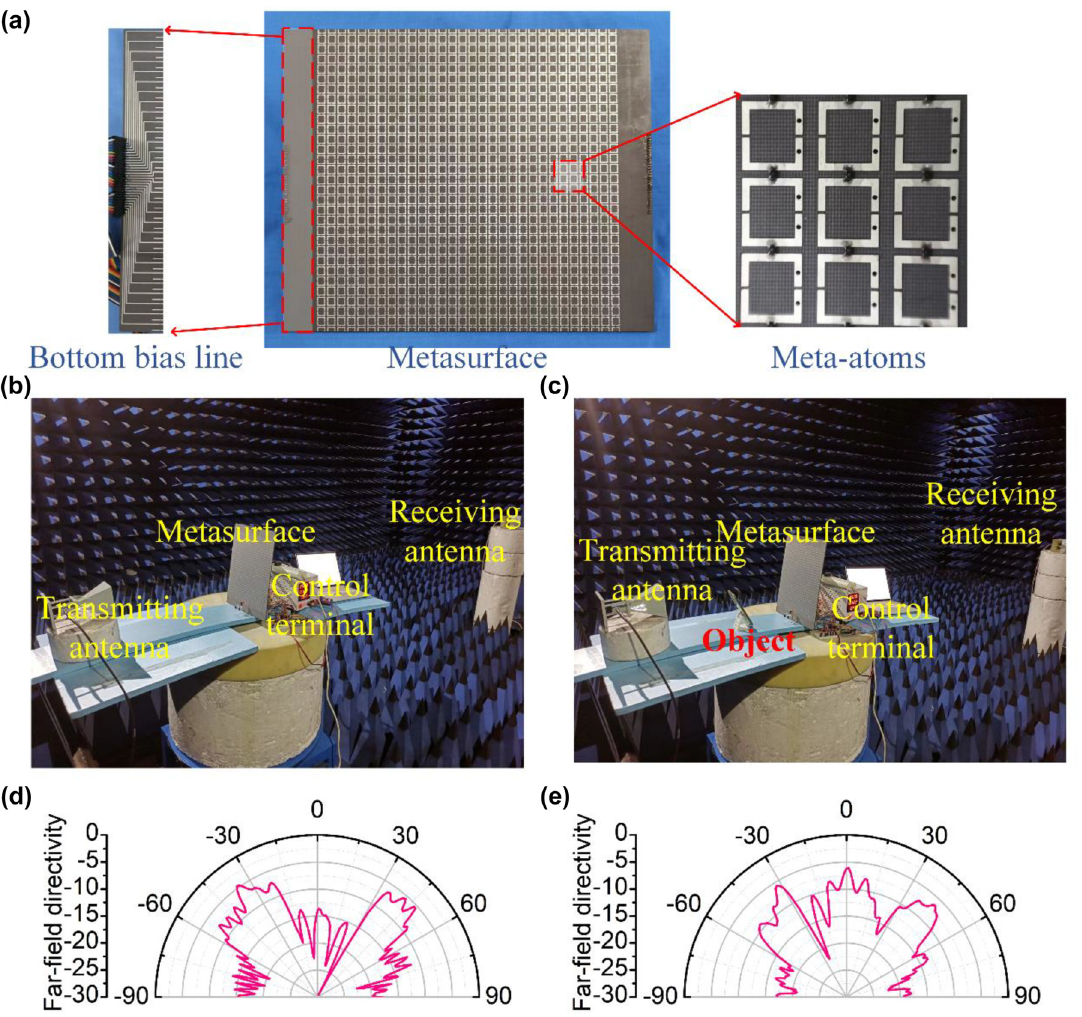
Figure 5: Sample demonstration and measurement verification of the metasurface: (a) photograph of fabricated metasurface prototype (b) far-field measurement environment in microwave anechoic chamber without object (c) far-field measurement environment in microwave anechoic chamber with object (d) the cross profile of far-field measured results of the scenario where object is no here (e) the cross profile of far-field measured results of scenario where object is